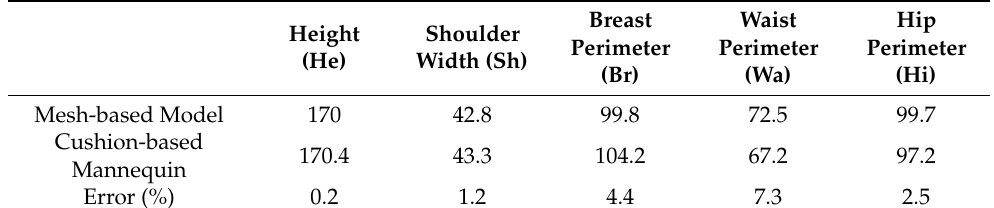
Table 6. Relative error between Mesh-based Model and Cushion-based Mannequin measurements (cm). Measurements performed with m T .